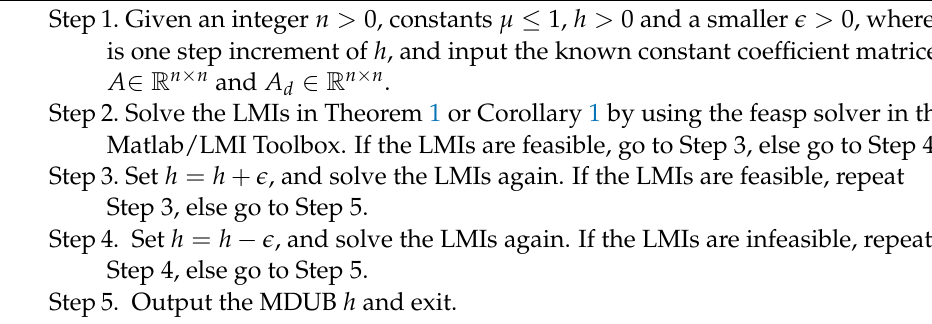
Algorithm 1: Obtaining the optimal value of h based on Theorem 1 or Corollary 1.